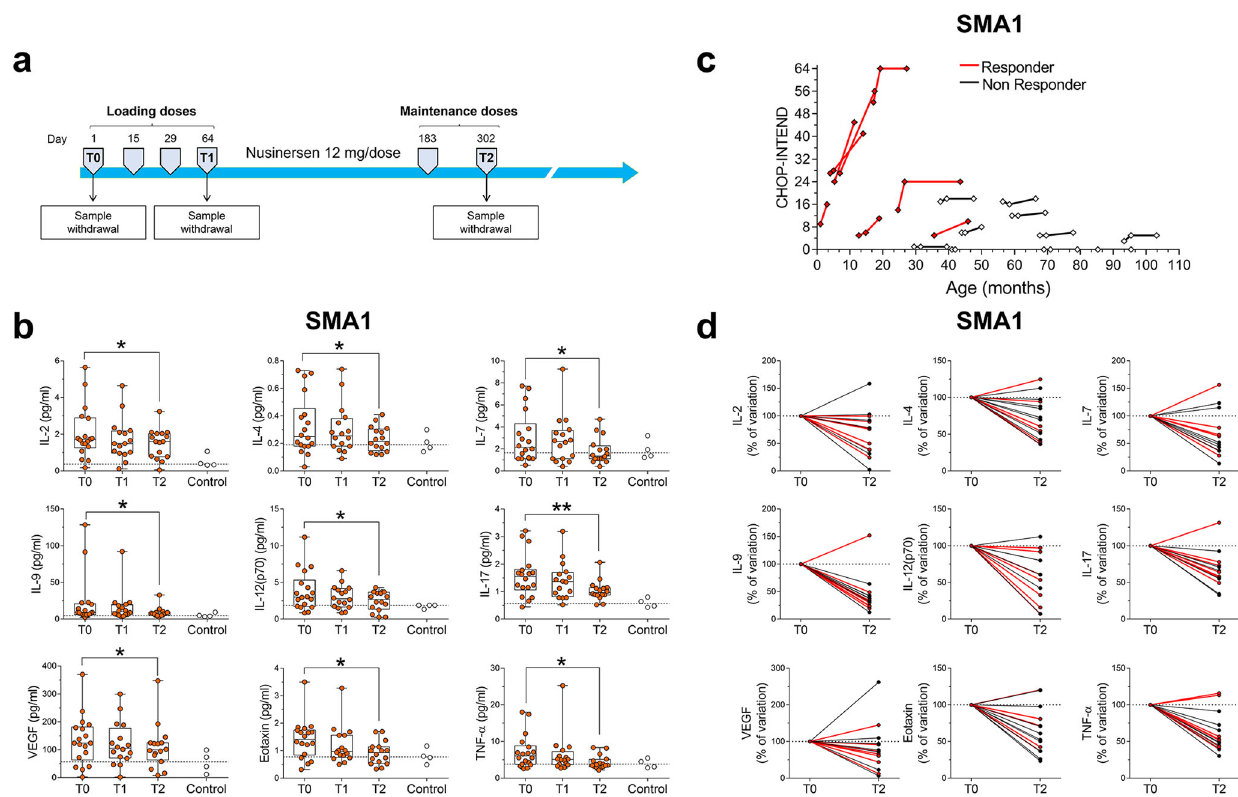
Fig. 2 Nusinersen decreases the levels of a subset of cytokines and neurotrophic factors in the CSF of SMA1 patients. a Schematic representation of the timeline of intrathecal Nusinersen administration and CSF collection in SMA patients. b Levels of IL-2, IL-4, IL-7, IL-9, IL-12, IL-17, VEGF, eotaxin, and TNF- α in the CSF of SMA1 patients prior to treatment (T0, n = 18) and at the time of the fourth (T1, n = 16) and the sixth (T2, n = 16) injection of Nusinersen. Controls ( n = 4) were used as a reference for physiological levels of cytokines. * p < 0.05, ** p < 0.01, com p ared to T0 (Wilcoxon matched-pairs signed ranks test). Data are shown as box and whisker plots representing median with interquartile range (IQR). Dots represent individual patients ’ values. The dotted line represents the median of control samples. c Spaghetti plots representing the CHOP-INTEND score of SMA1 patient at T0, T1, and T2. d Spaghetti plots showing variations of cytokines levels in the CSF of SMA1 patients between T0 and T2. Cytokines variations are expressed as percentage of the T0 values (expressed as 100%). Patients are indicated as “ responders ” (red lines) or “ non-responders ” (black lines) to Nusinersen